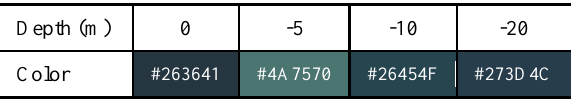
Table 2. Color palette extracted from the